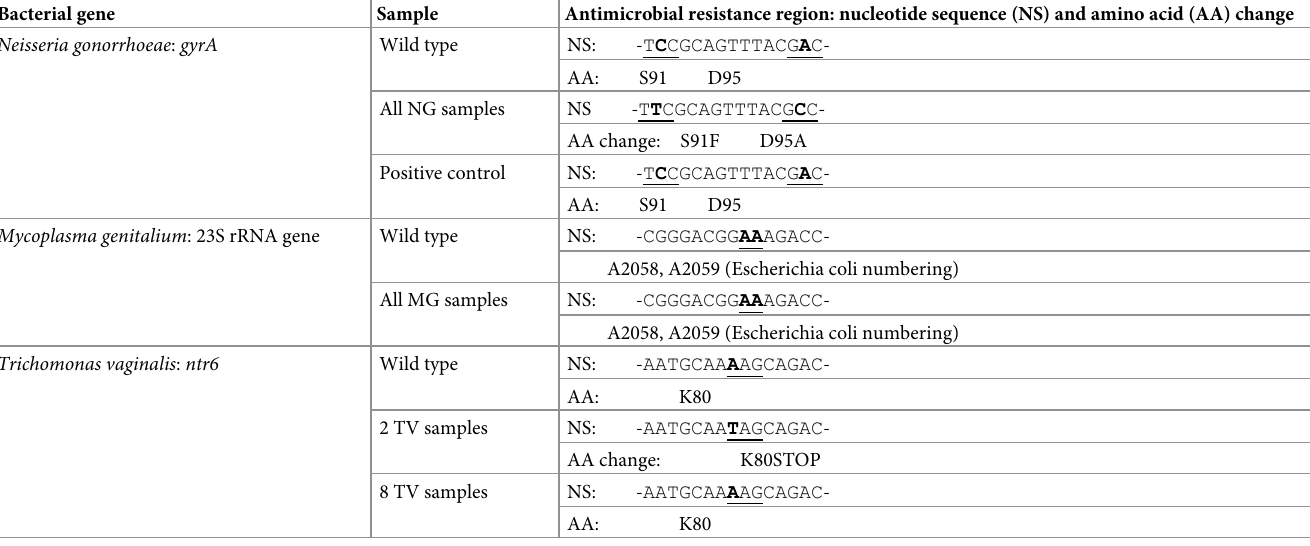
Table 3. BLAST confirmation of antimicrobial resistance associated mutations identified by single gene targeted PCR nanopore sequencing � . Bacterial